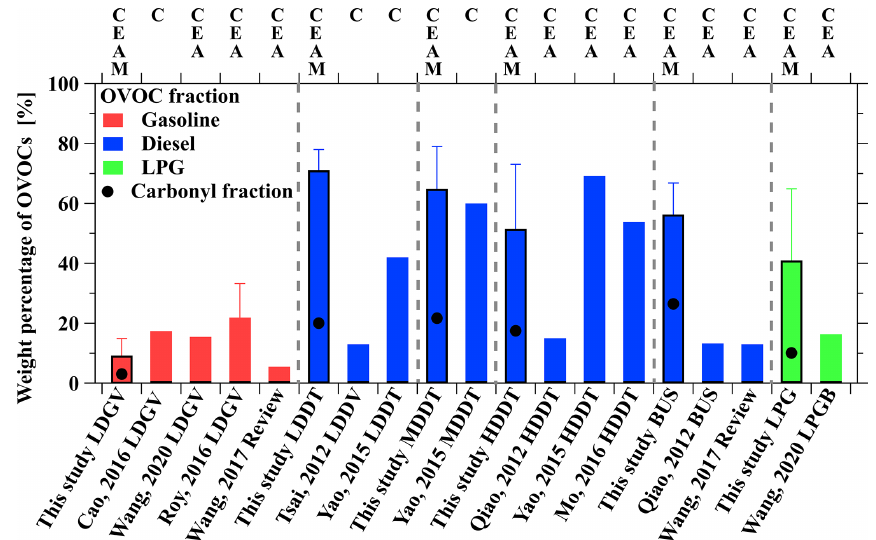
Figure 12. Comparison of OVOC fractions determined in this study and those in previous studies. Error bars represent the standard deviations of the weight percentage of OVOCs. The C, E, A, and M above the top axis represent the four groups of OVOCs measured in this study or previous studies, including carbonyl (C), ester/ether (E), alcohol (A), and multiple-functional